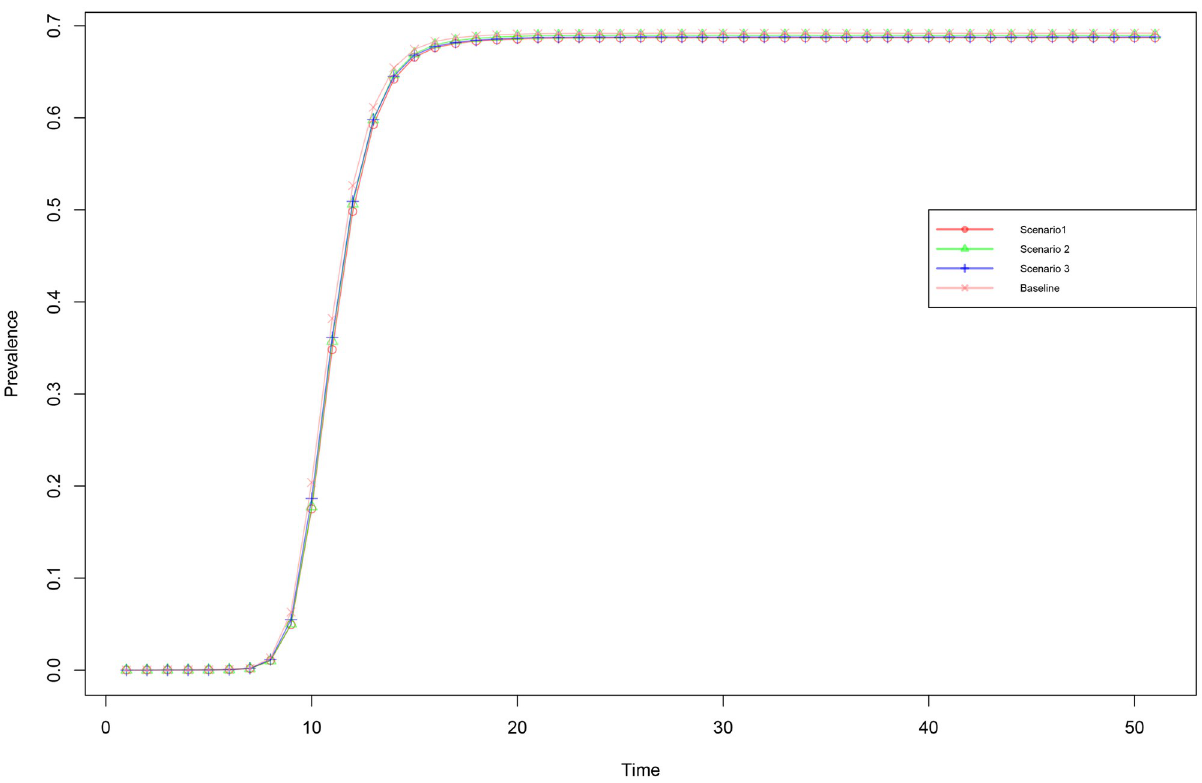
Fig 2. For network 1 with random seeding the mean prevalence over time is depicted for the four scenarios with the same overarching propagation likelihood ( λ = 0.192). Scenario1, the red open circles, is a process with α = 0.4, ϕ = 0.6 and η = 0.8. Scenario2, the green triangles, a process with α = 0.6, ϕ = 0.8 and η = 0.4. Scenario3, blue pluses, a process with α = 0.8, ϕ = 0.4 and η = 0.6. Scenario 4, the pink crosses, a process with homogeneous sub-processes ( α = ϕ = η =